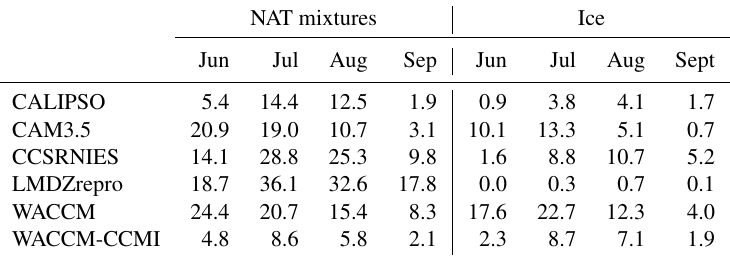
Figure 5. The vertical extent (in km) for NAT mixtures, ice, enhanced NAT mixtures and STS (from top to bottom) obtained from CALIOP observations, averaged over 5 years for June, July, August and September (left to right) is displayed. In the left column, the location of McMurdo is indicated with a yellow asterisk. The fraction of the overall air volume (between 12 and 30km height south of 60 ◦ S) occupied by different PSC classes for each month is reported in the top-right corner. The color scale indicates the number of km occupied by PSCs between 12 and 30km. Table 5. Total PSC frequencies (in %) in the 12–30km height layer for NAT and ice clouds for June–September for the observations and models. Note that CALIPSO NAT includes the enhanced NAT mixtures